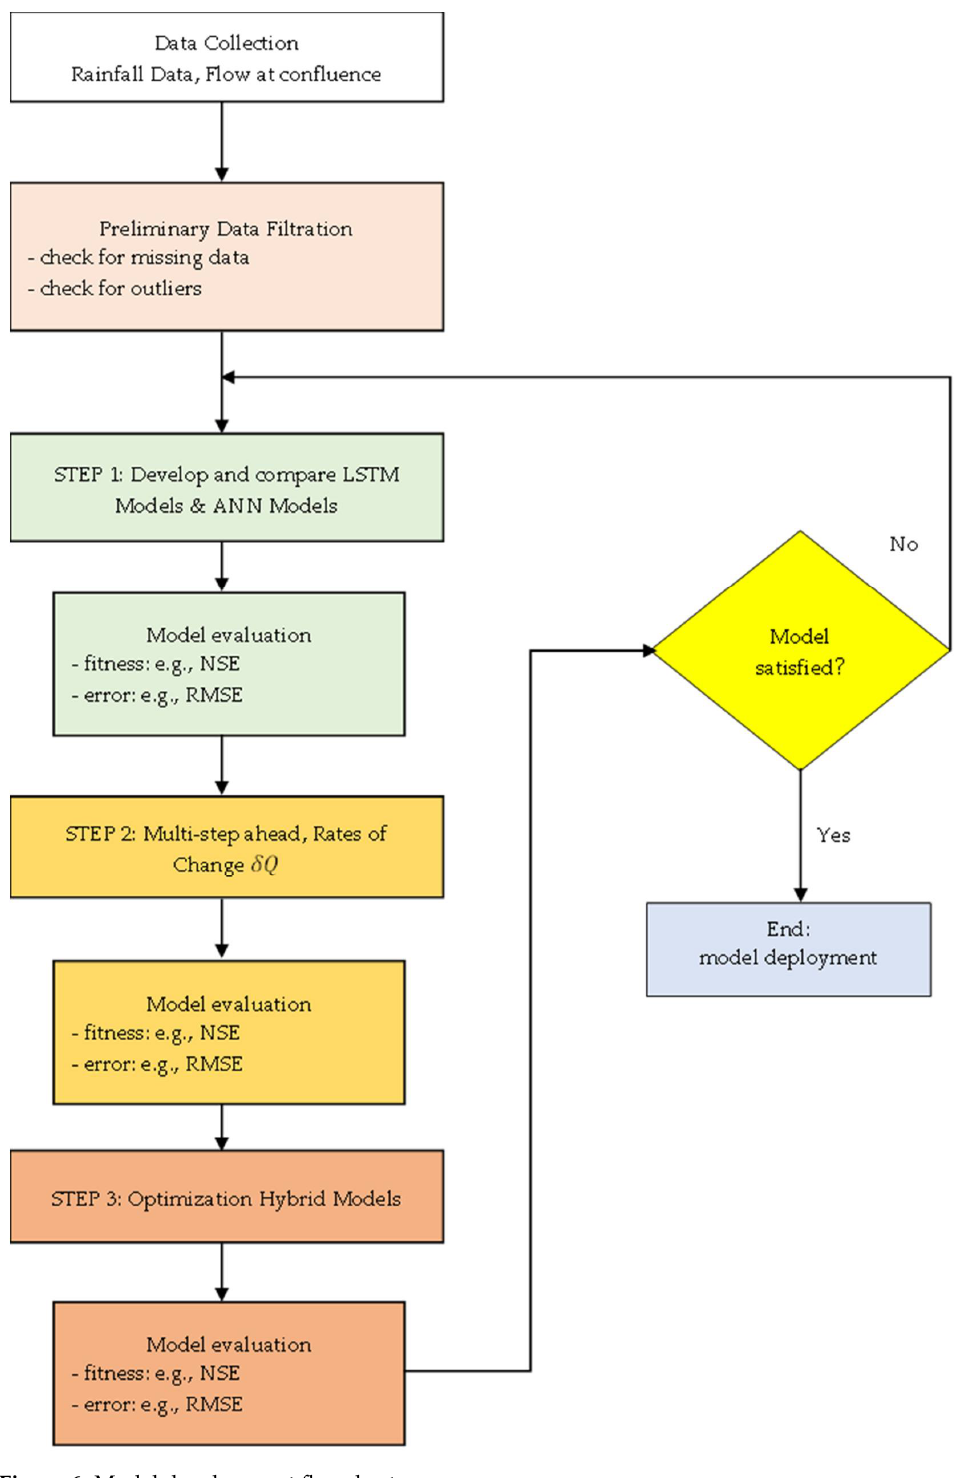
Figure 6. Model development flowchart.